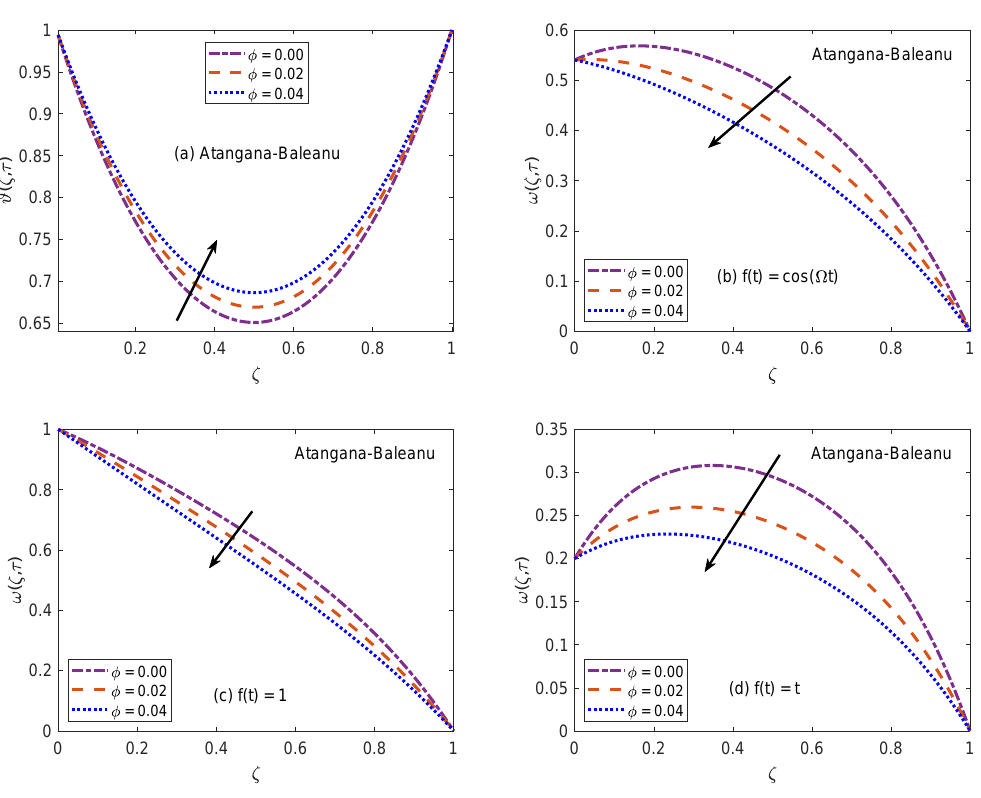
Figure 4. Temperature and velocity patterns of AB model for variation of φ .